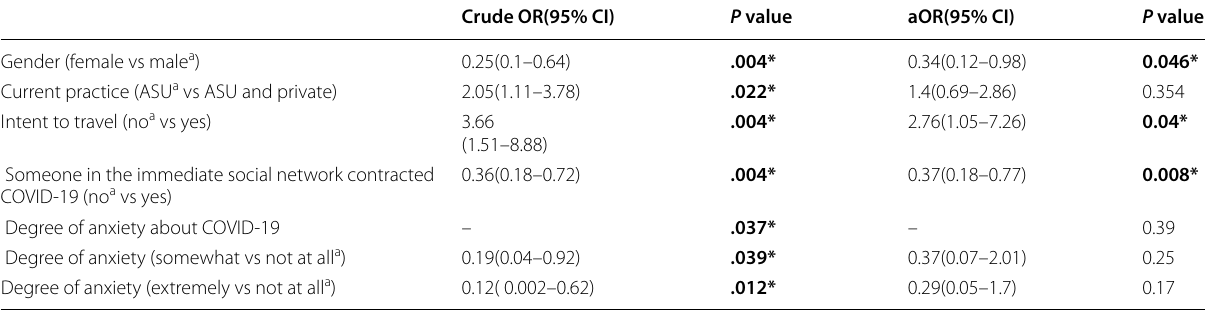
Table 3 Predictors of willingness of dental teaching staff of the Faculty of Dentistry, Ain Shams University to receive COVID-19 vaccine ( N 171) =